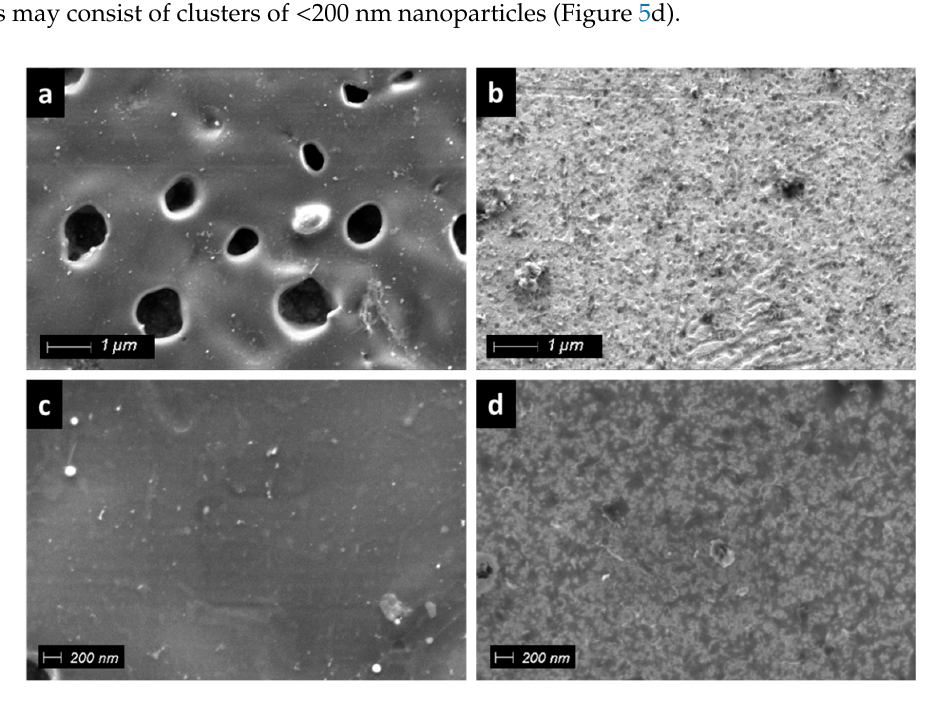
Figure 5 . FE-SEM images of 1 c ( a , c ) and 1 b ( b , d ). Figure 5. FE-SEM images of 1c ( a , c ) and 1b ( b , d